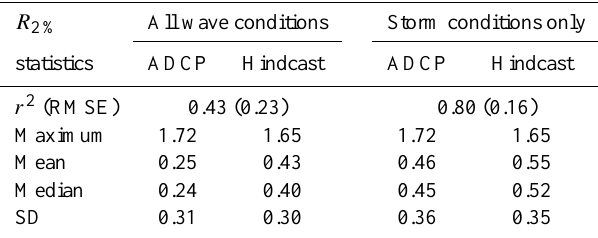
Table 7. Extreme run-up statistics for measured and hindcasted wave conditions during a 3-year time period (2011–2013). The er- ror analysis and statistics correspond to all wave conditions and only storm conditions. R